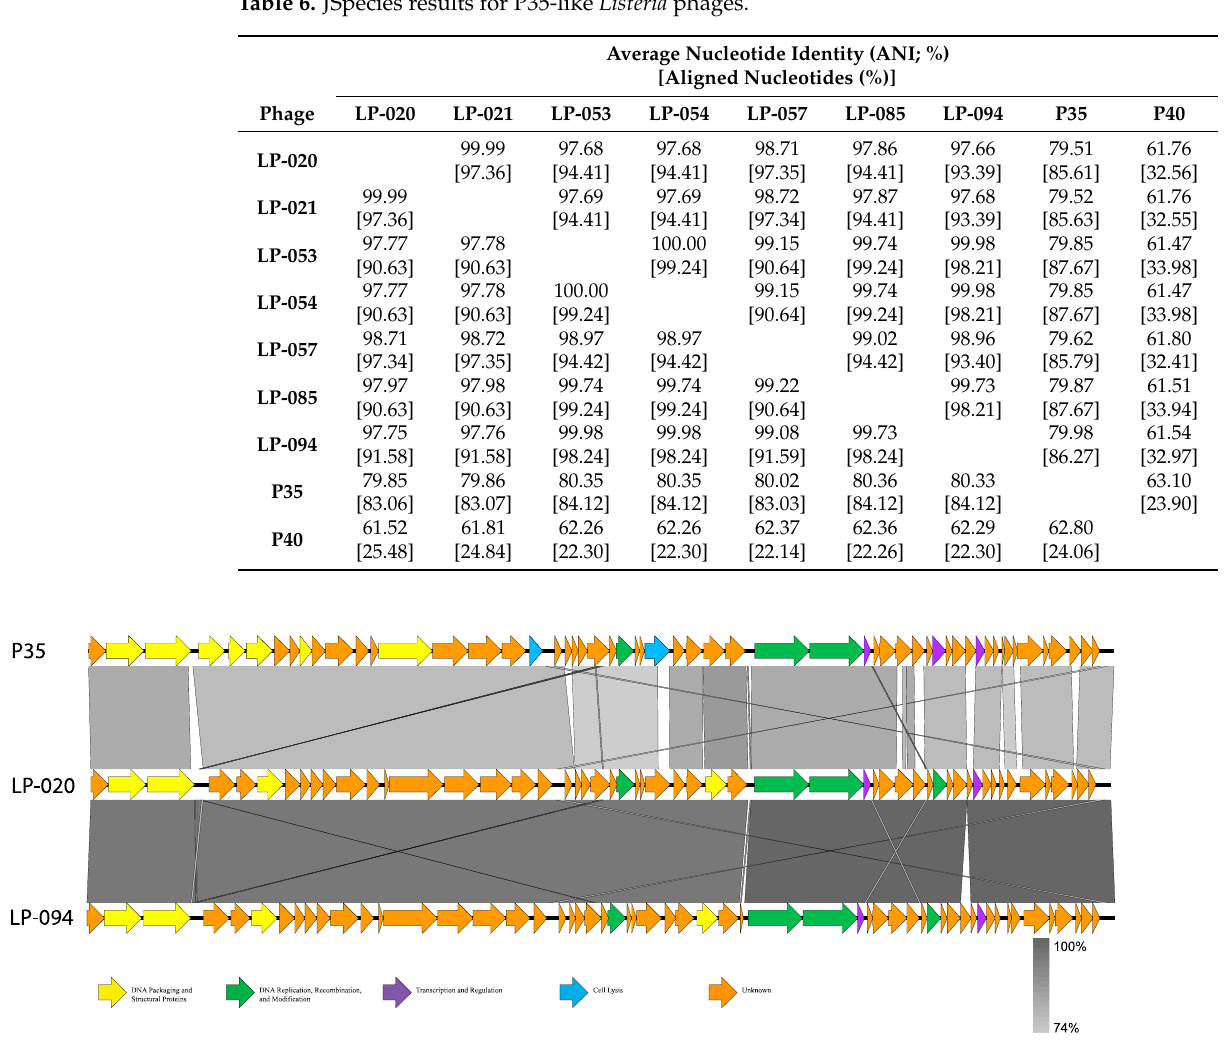
Table 6. JSpecies results for P35-like Listeria phages.